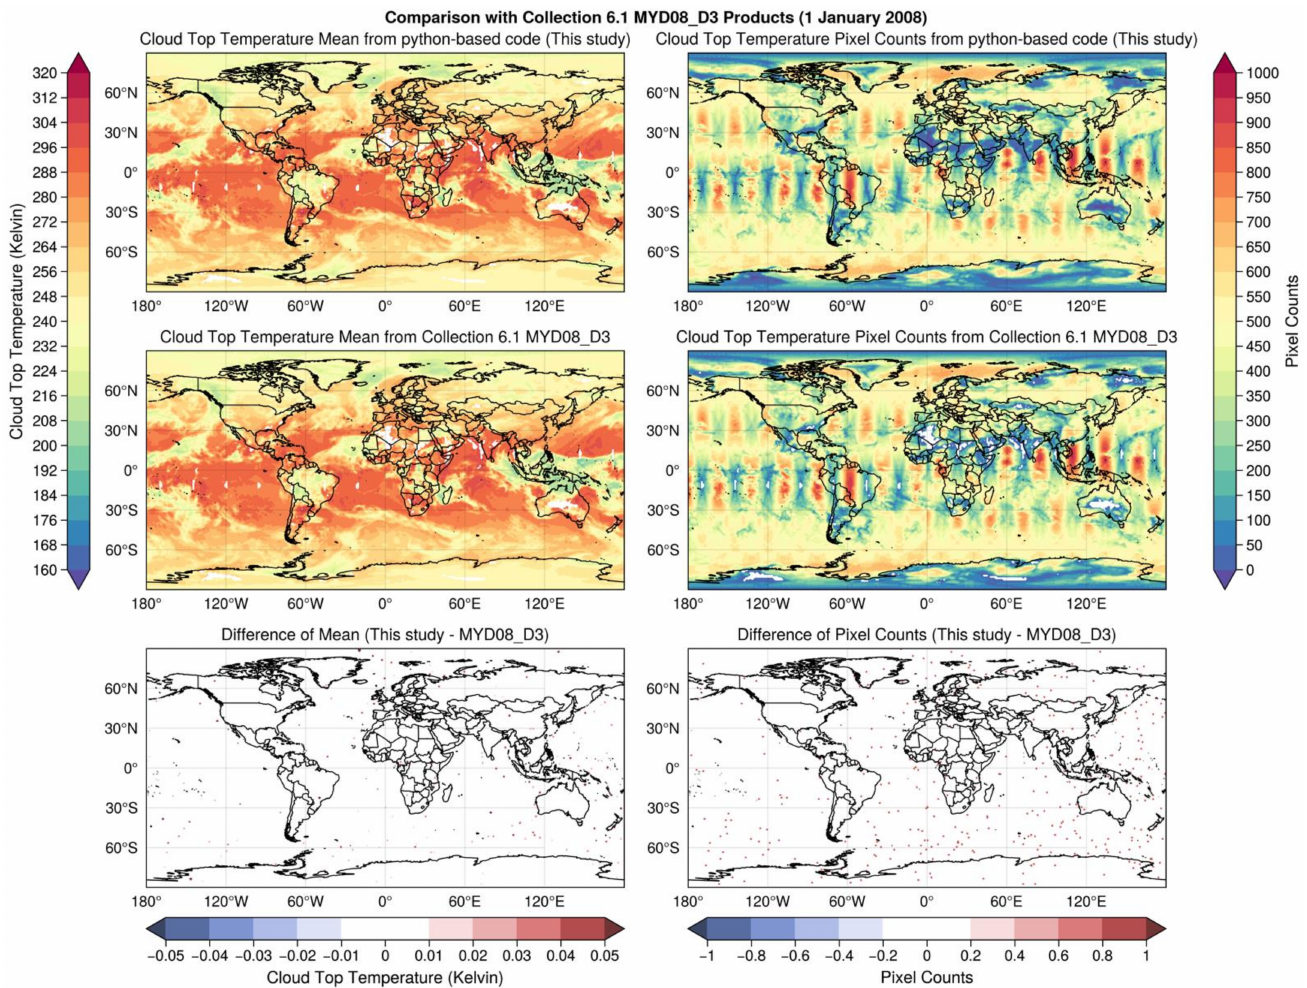
Figure 3. The comparison of the mean value and pixel counts of cloud top temperature between the python-based flexible aggregation algorithm and the MYD08_D3 product on 1 January